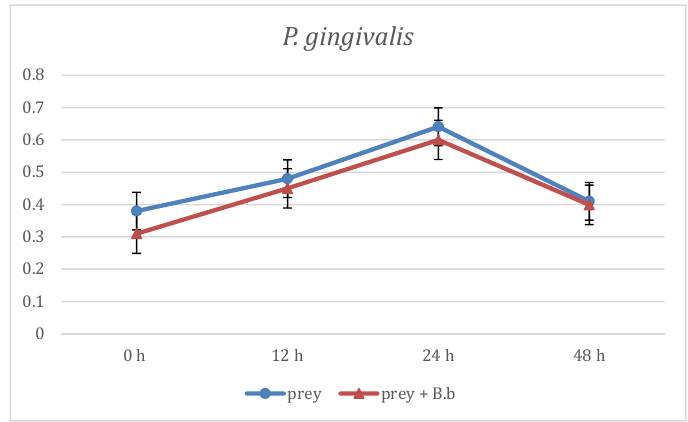
Figure 5. Predation activity of B. bacteriovorus against P. gingivalis . Materials 2019 , 12 , x FOR PEER REVIEW